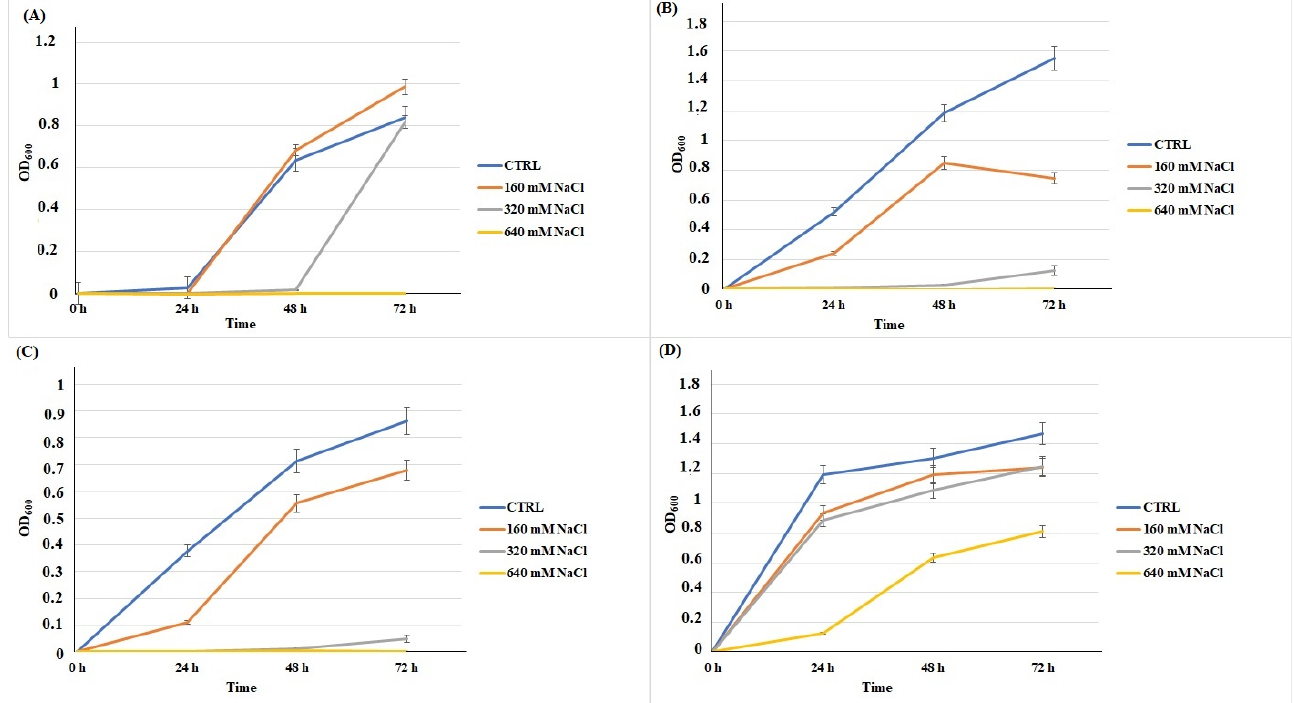
Figure 1. Growth curves of A. brasilense ( A ), B. ambifaria ( B ), H. seropedicae ( C ), and Pseudomonas sp. ( D ) in TSB media, along with different amounts of NaCl. Table 1. Shoot length, roots length, and fresh weight of B. napus cv. SY Saveo grown for 30 days on non-saline soil (C) or saline soil (S). Plants were inoculated with plant growth-promoting bacteria (A = A. brasilense , B = B. ambifaria , G = A. globiformis , H = H. seropedicae , U = Pseudomonas sp. UW4) or not (N.I. = non-inoculated). Different letter means significant difference within the same bacterial treatment. Significant differences between inoculated or non-inoculated plants grown at the same soil condition are marked as * ( p < 0.05), *** ( p < 0.001) ( n =